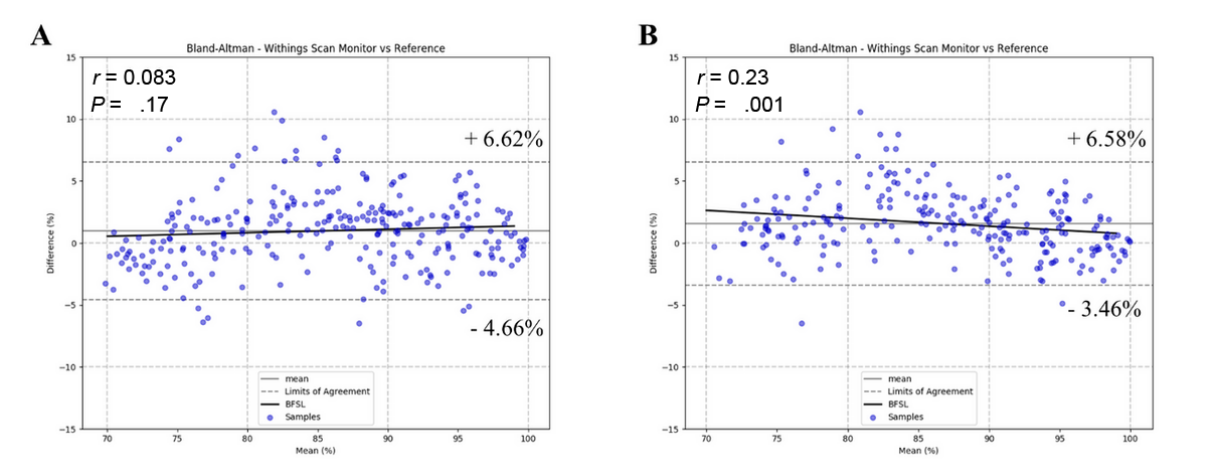
Figure 5. Bland-Altman plots for the Withings ScanWatches and the ABL90 hemoximeter from the participants’ right (A) and left (B) hands. BFSL: best fit straight